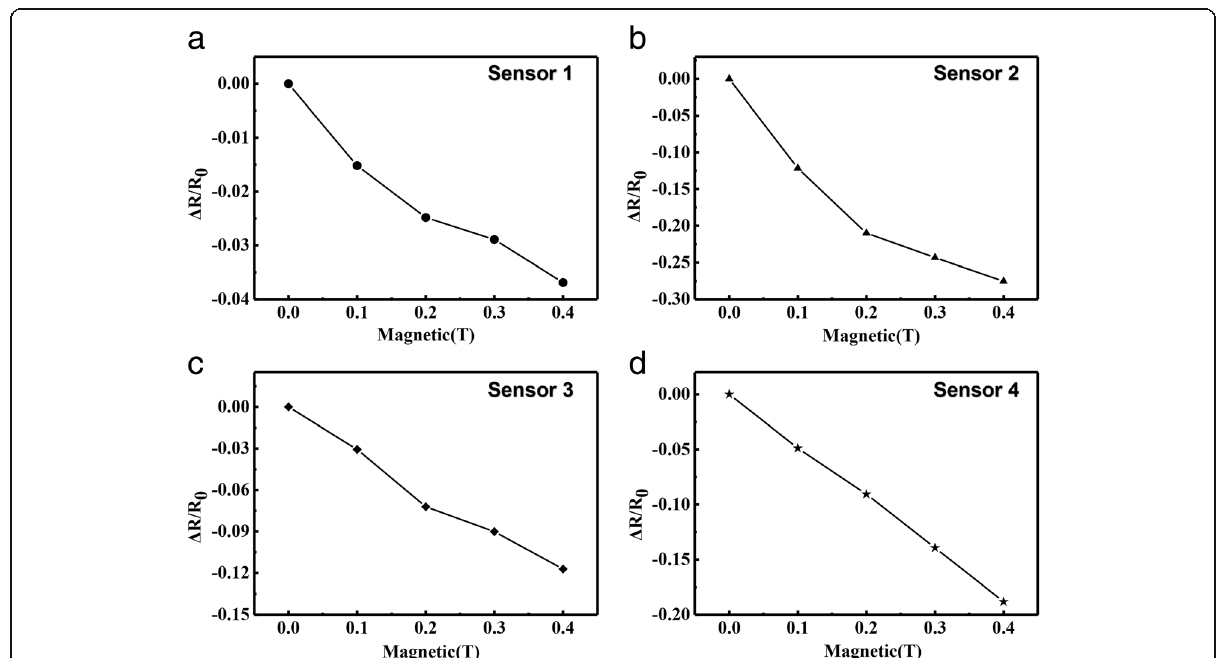
Fig. 7 The resistance changes in different magnetic